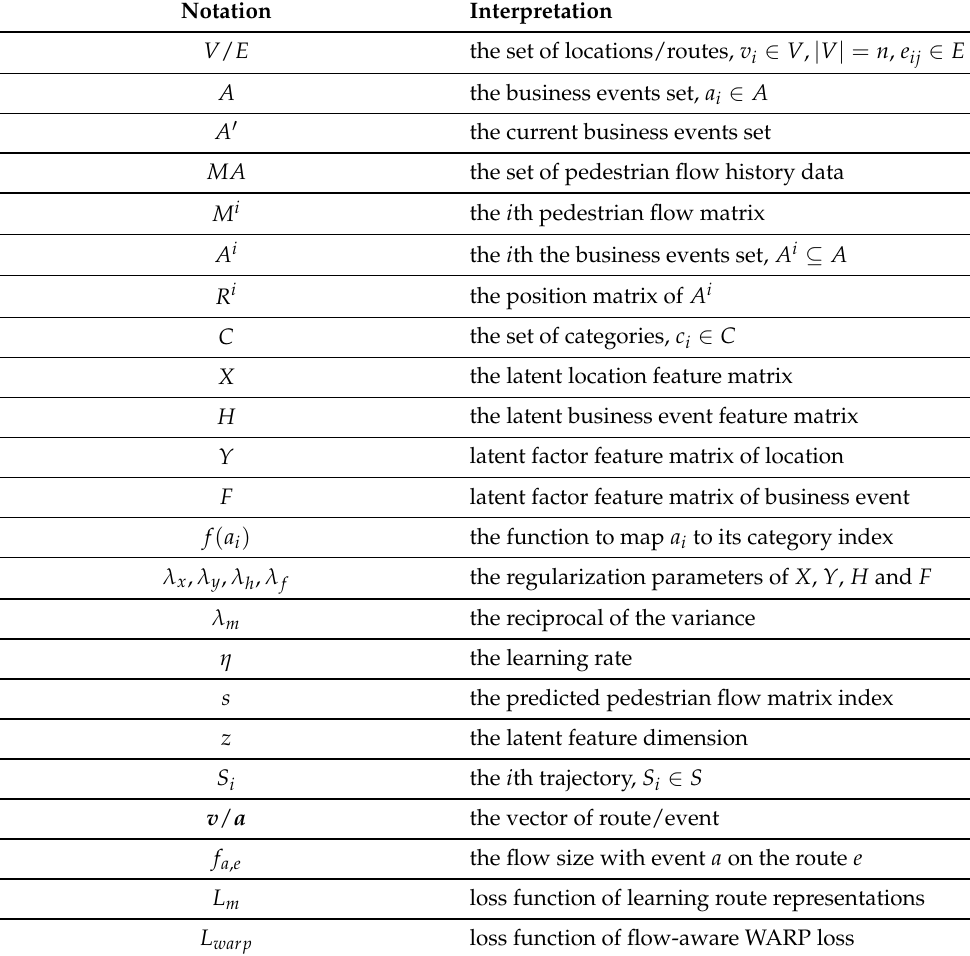
Table 1. Frequently-used